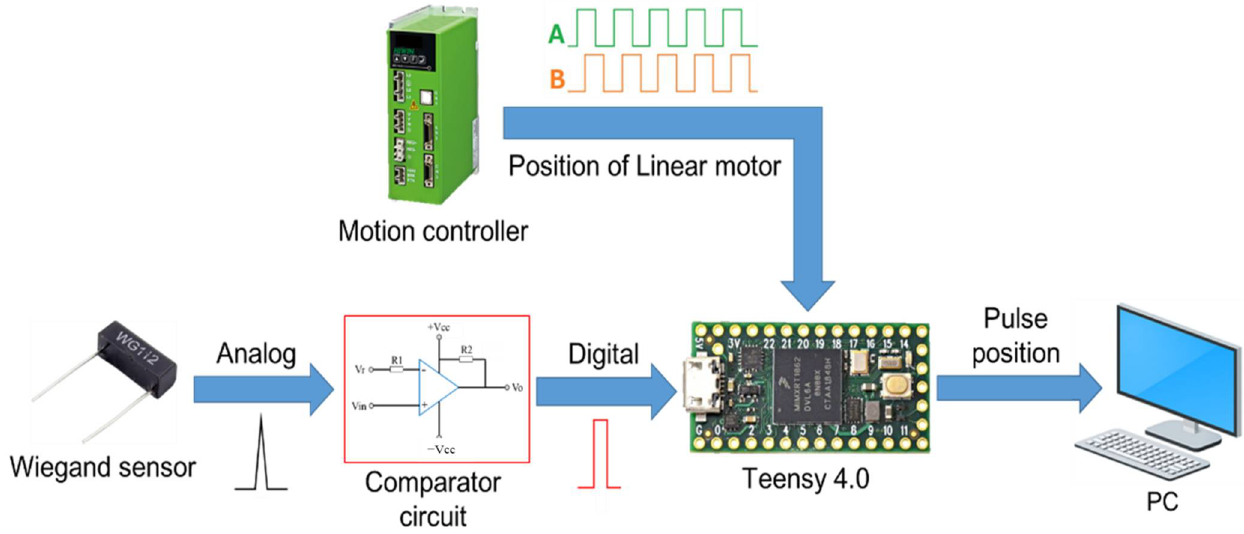
Figure 5. Process of measuring repeatability of the Wiegand pulse.